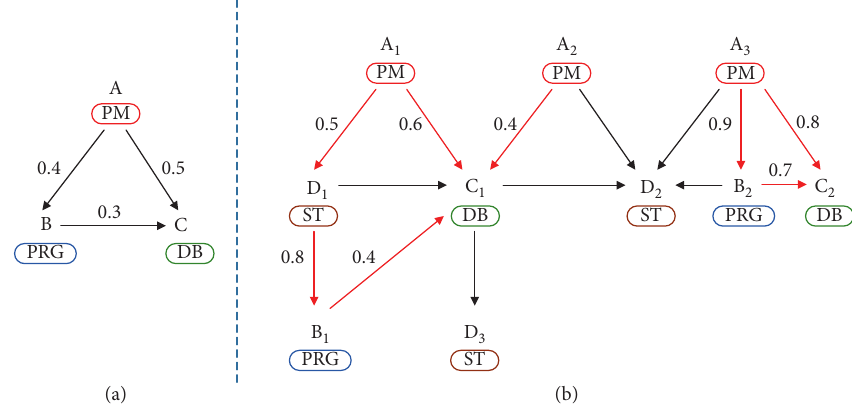
Figure 1: Querying collaboration network: (a) pattern graph Q ; (b) data graph G